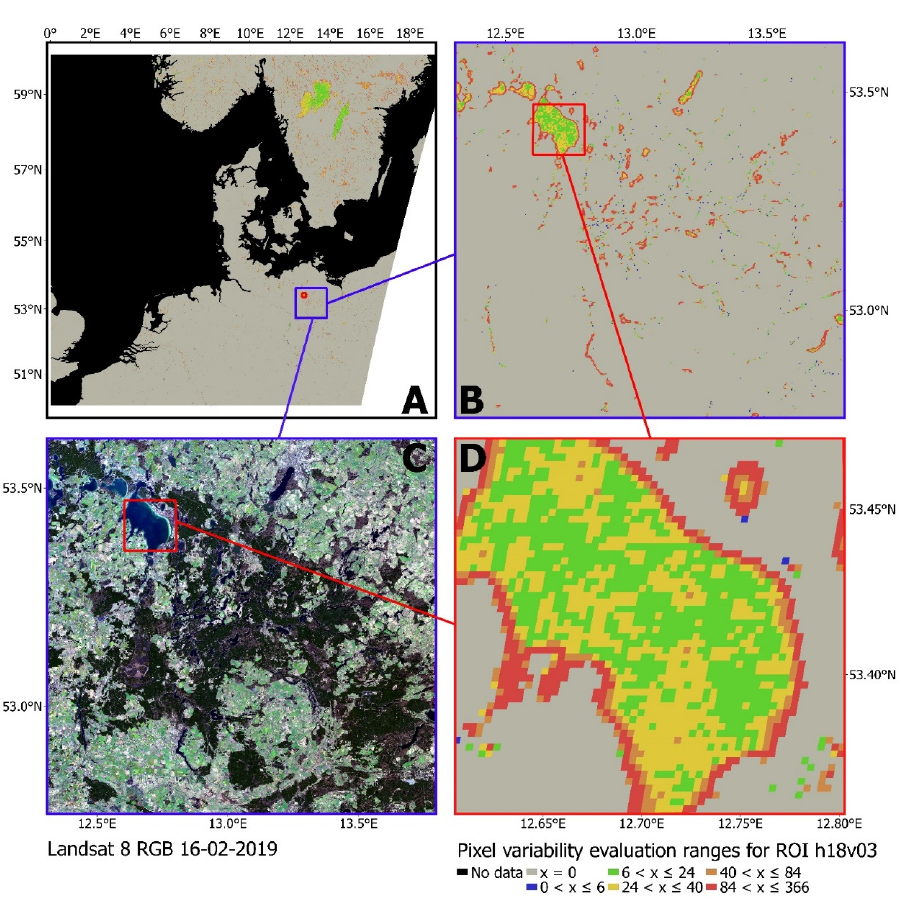
Figure 7. Evaluation ranges according to pixel variabilities (water/non-water state changes) over 3652 days (2010–2019) for test ROI h18v03: ( A ) complete ROI tile (1:8,500,000), ( B ) zoomed-in tile